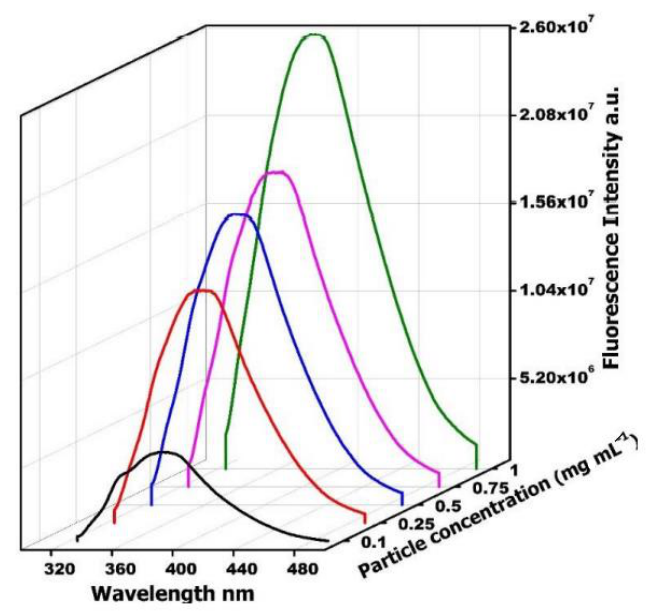
Figure 12. The influence of Zr-GO composite on fluorescence intensity of TA; Reaction conditions: 2 mM TA, 500 µ M H 2 O 2 , 5 µ g mL − 1 of GO and ZrCl 4 with different concentrations (0.1, 0.25, 0.5, 0.75, 1 mg mL − 1 ) in DI water incubated for 30